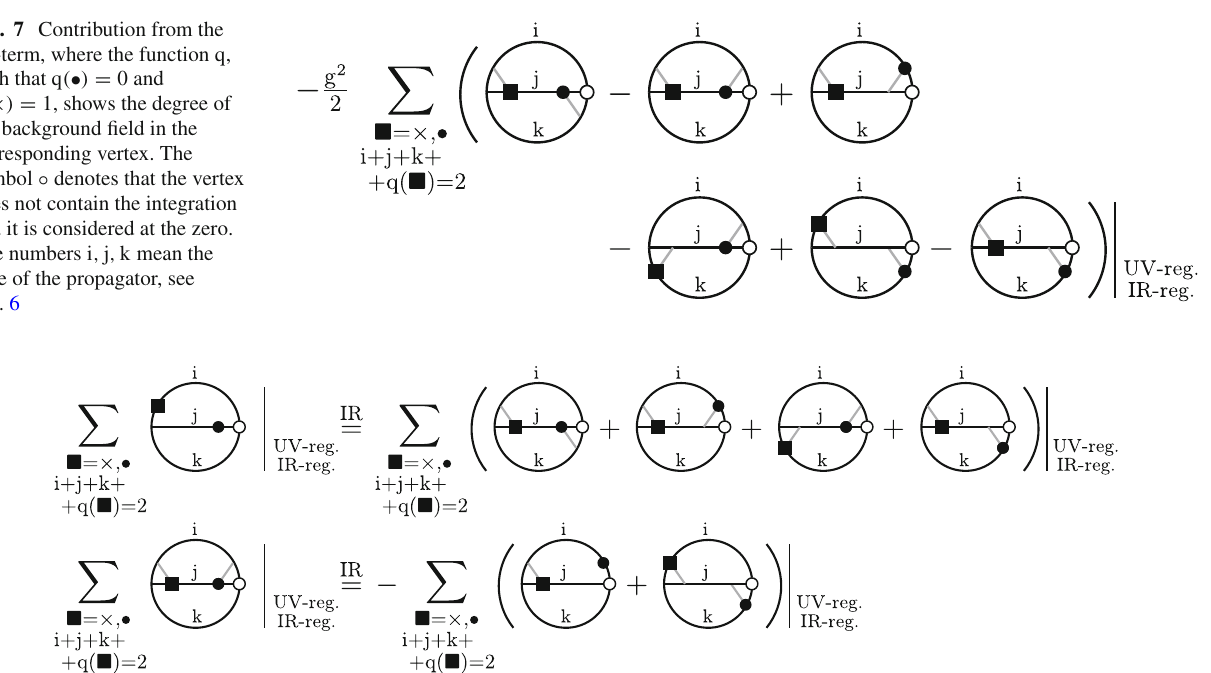
Fig. 7 Contribution from the (cid:5) 2 -term, where the function q, 3 such that q ( • ) = 0 and q ( × ) = 1, shows the degree of the background field in the corresponding vertex. The symbol ◦ denotes that the vertex does not contain the integration and it is considered at the zero. The numbers i , j , k mean the type of the propagator, see Fig. 6